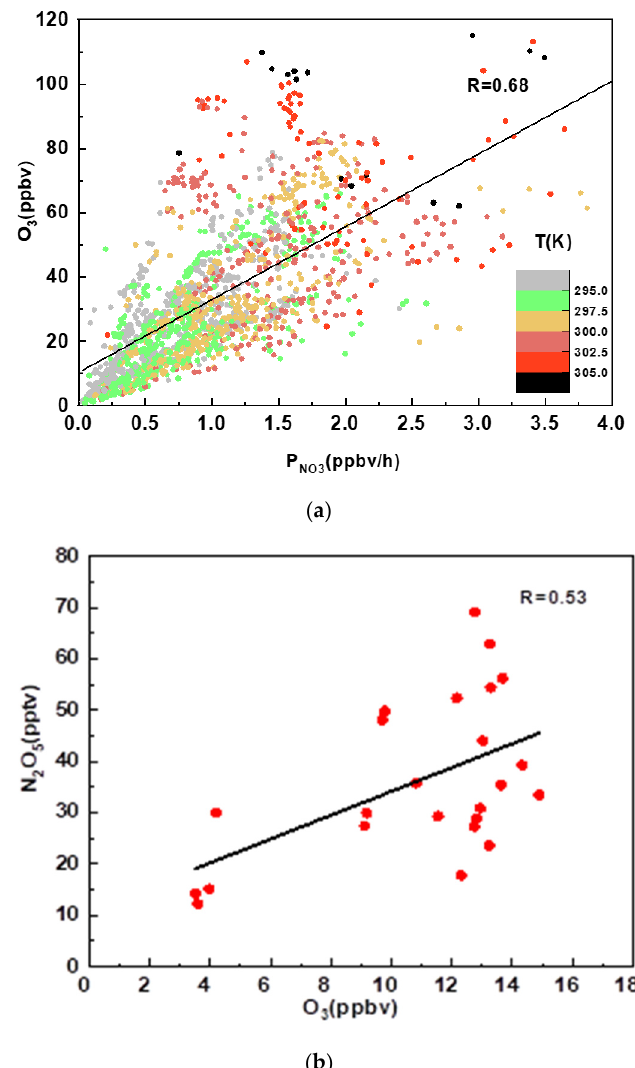
Figure 5. ( a ) The dependence of P(NO 3 ) on the O 3 concentration. The black line shows linear fitting. ( b ) The dependence of N 2 O 5 on the O 3 concentration. The black line shows linear fitting.